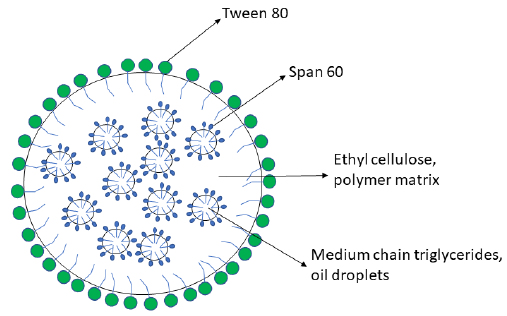
Figure 1. Schematic representation of lipomers.